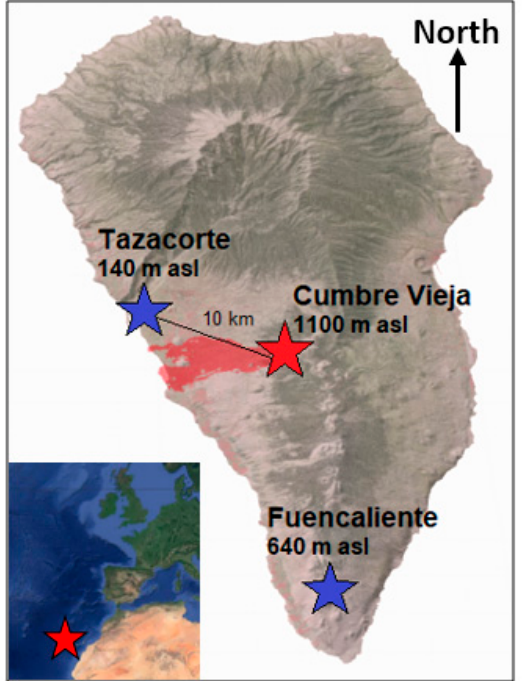
Figure 1. Geographical position of Cumbre Vieja volcano and Tazacorte site in La Palma Island. The red-shaded area represents the extension of the area affected by the lava flow. Credits: https://ign-esp.maps.arcgis.com/ (last accessed on 19 January 2022). Insert from Google Maps.